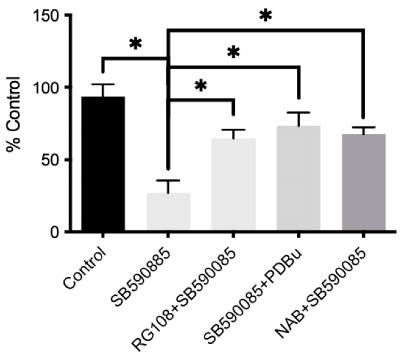
Figure 11. The bar graph demonstrates VSCs viability following incubation with the B-Raf inhibitor. It shows that a DNMT inhibitor (RG108), PKC activator (PDBu), and an HDAC inhibitor (Sodium Butyrate—NAB) were able to rescue B-Raf inhibition-mediated VSCs apoptosis. * Denotes p < 0.05, n = 5.